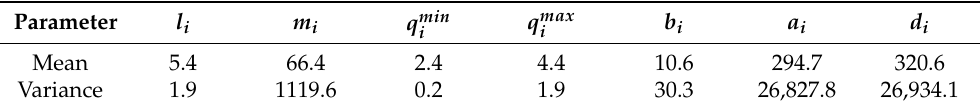
Table 2. The means and variances of the Parameter of the